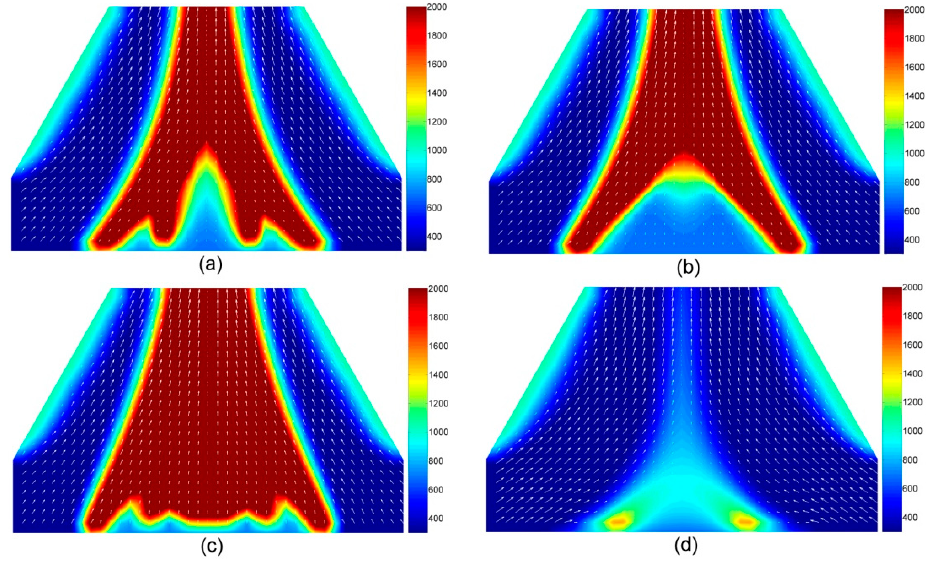
Figure 4. Temperature and gas velocity in gas phase for 10 mm thickness PMMA under 75 kW/m 2 heat flux at: ( a ) 100 s; ( b ) 200 s; ( c ) 300 s; and ( d ) 400 s. heat flux at: ( a ) 100 s; ( b ) 200 s; ( c ) 300 s; and ( d ) 400